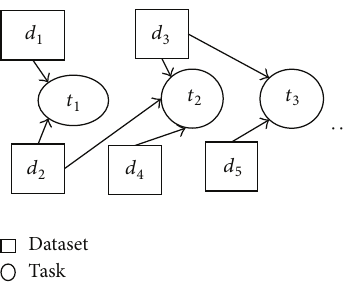
Figure 1: Tasks and